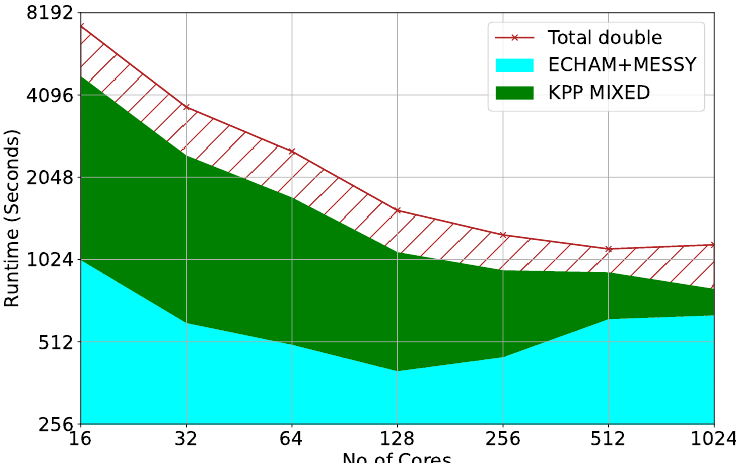
Figure 6. Time-to-solution for EMAC model in QCTM configuration at T42L90 resolution: circulation dynamics ECHAM and physics MESSy (Cyan), and total required runtime in double precision (red). The red hatched area indicates the improvement in runtime that can be achieved by the mixed-precision KPP compared to the double-precision KPP.